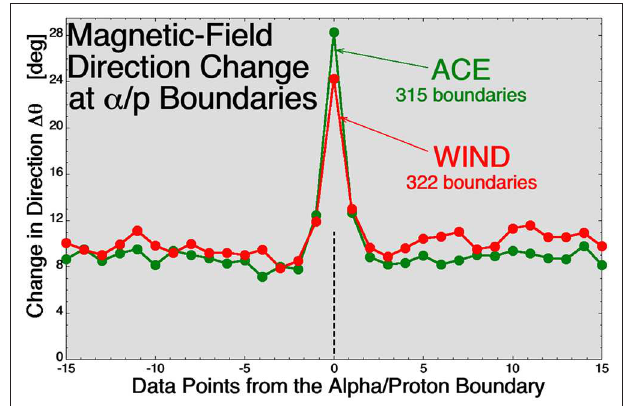
FIGURE 2 | For 315 α /p boundaries located with the ACE spacecraft (green) and for 322 α /p boundaries located with the WIND spacecraft, the superposed-epoch average of the magnetic-field vector direction change (over 64-s for ACE and over 97-s for WIND) is plotted with the zero epoch being the α /p boundary crossing